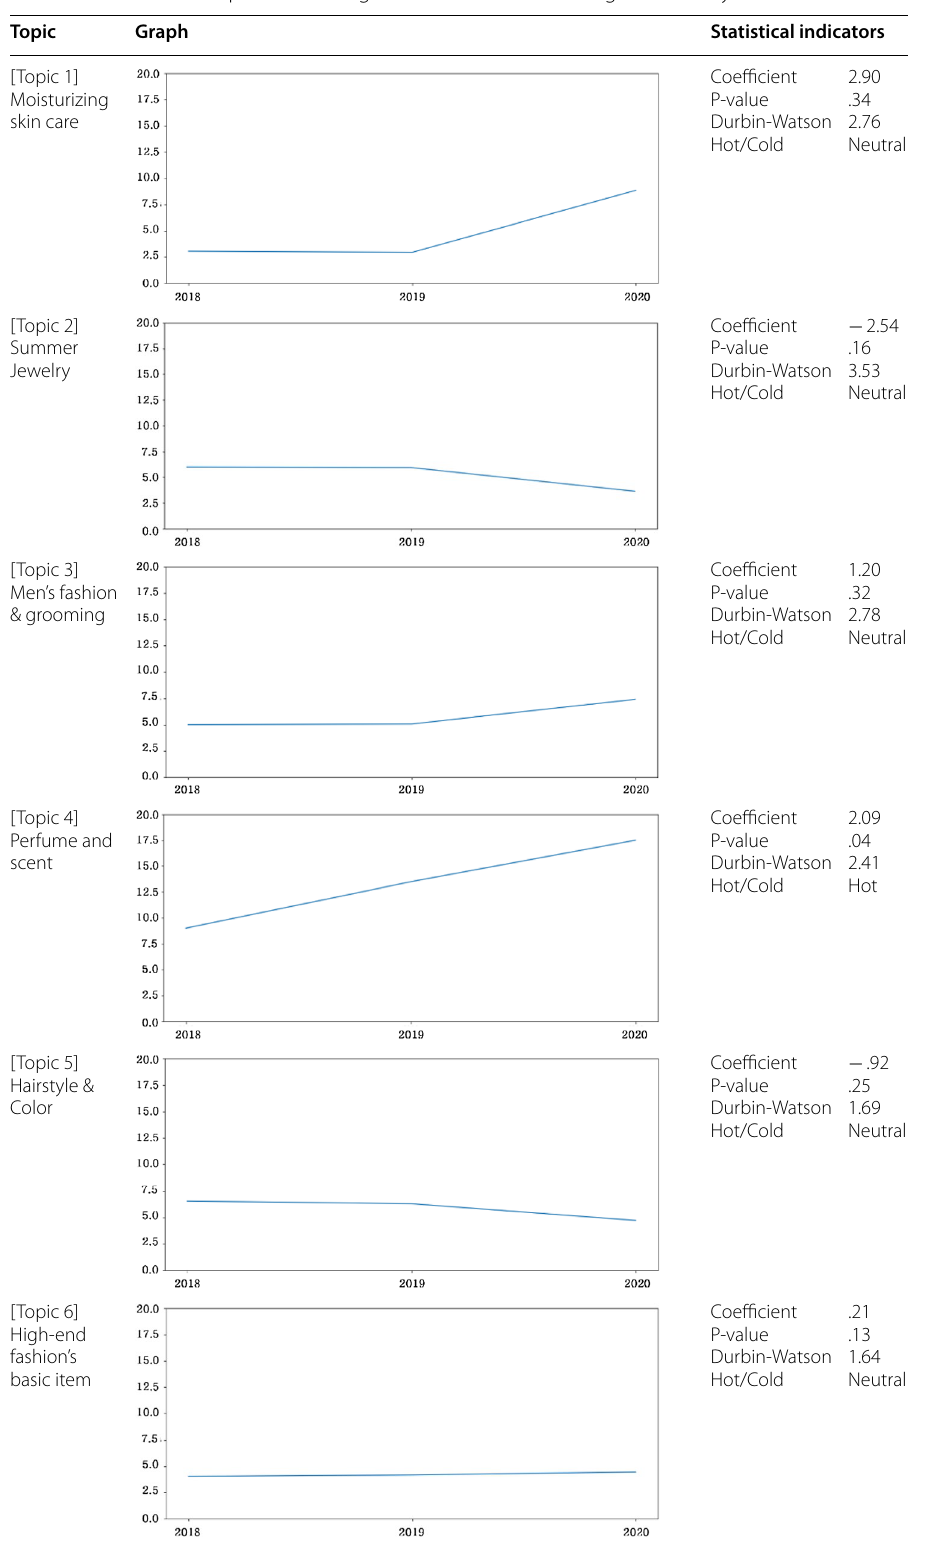
Table 4 Result of the topic trend change after time series linear regression